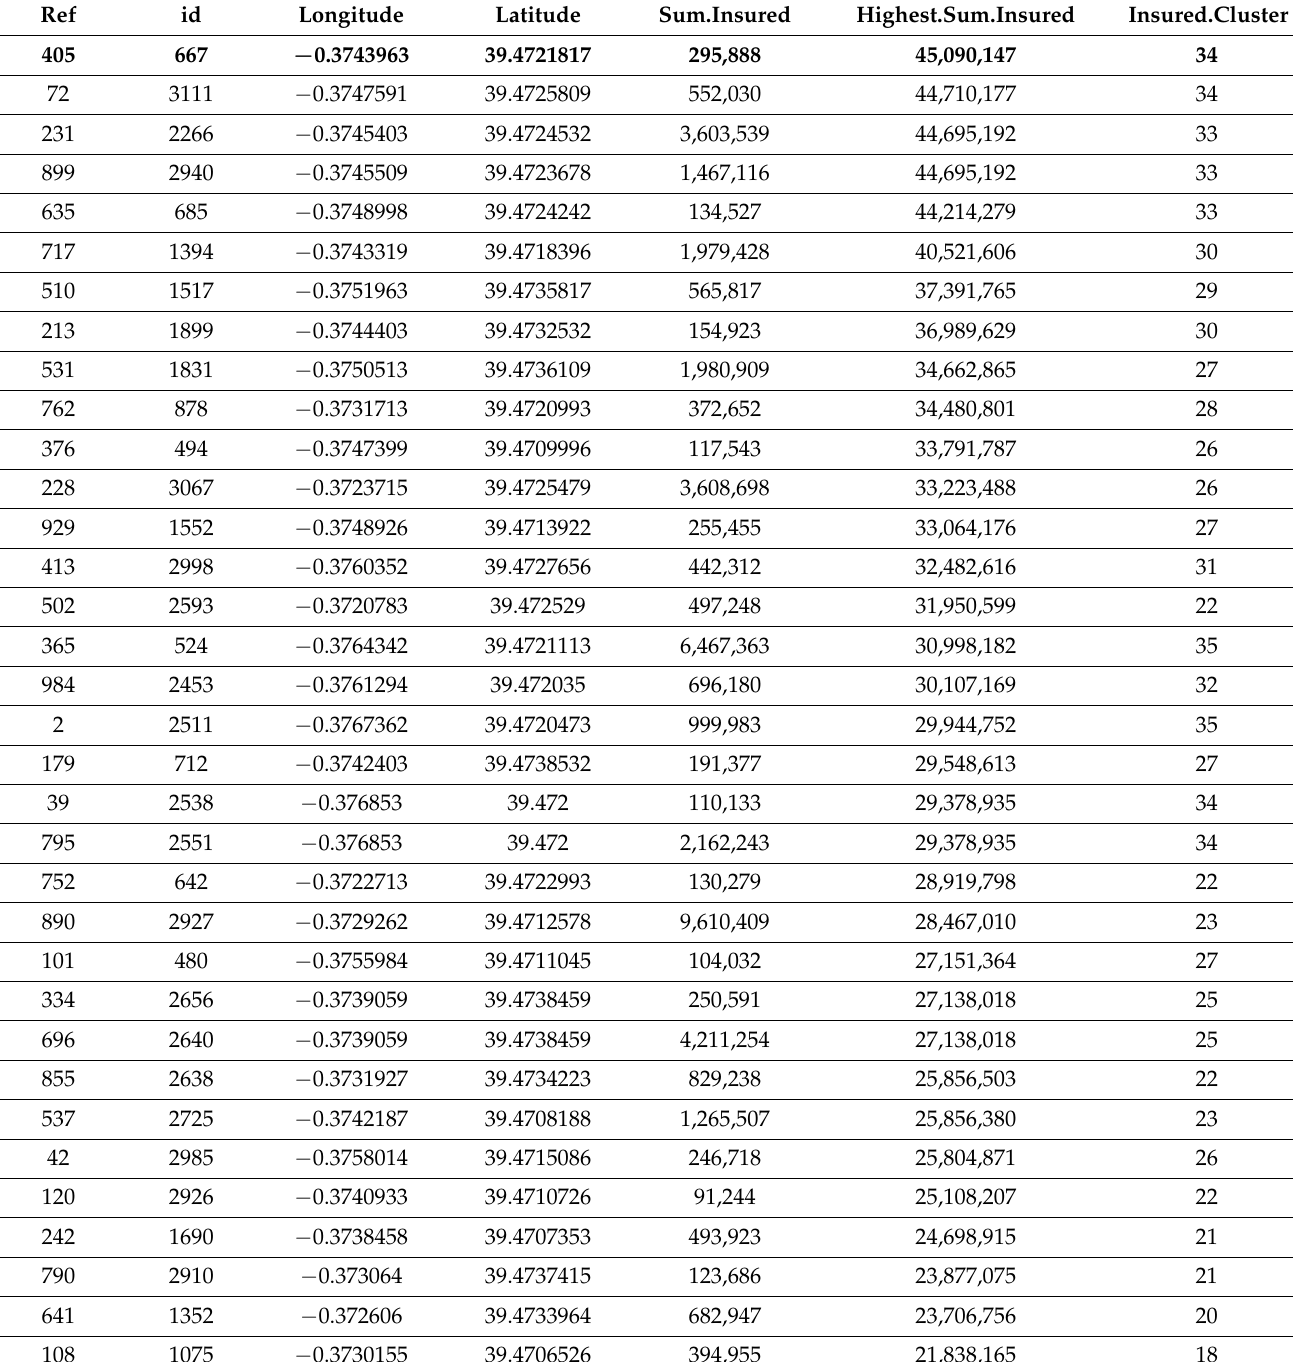
Table 3. The highest risk cluster for the insurance entity. Scenario 2 (Haversine